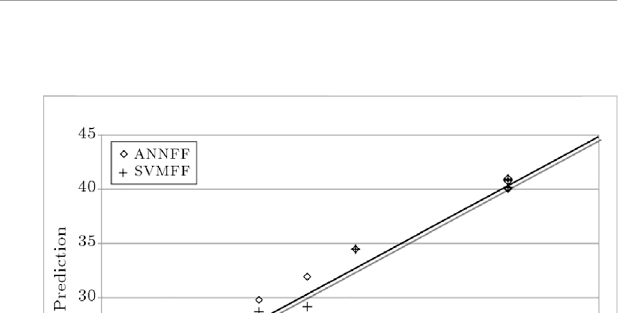
FIGURE 4 Architecture of used ANN (Rashidian and Hassanlourad, 2014).